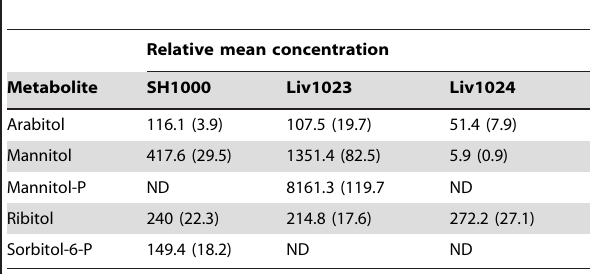
Table 2. Sugar alcohols present in S. aureus